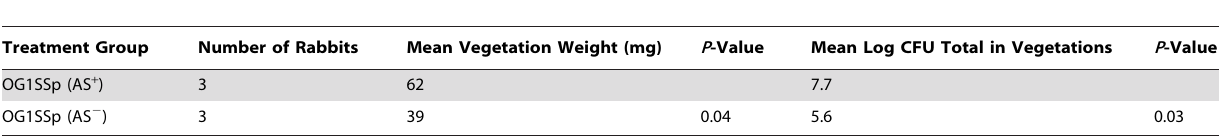
Table 1. Enterococcal aggregation substance enhances vegetation production in endocarditis in rabbits.